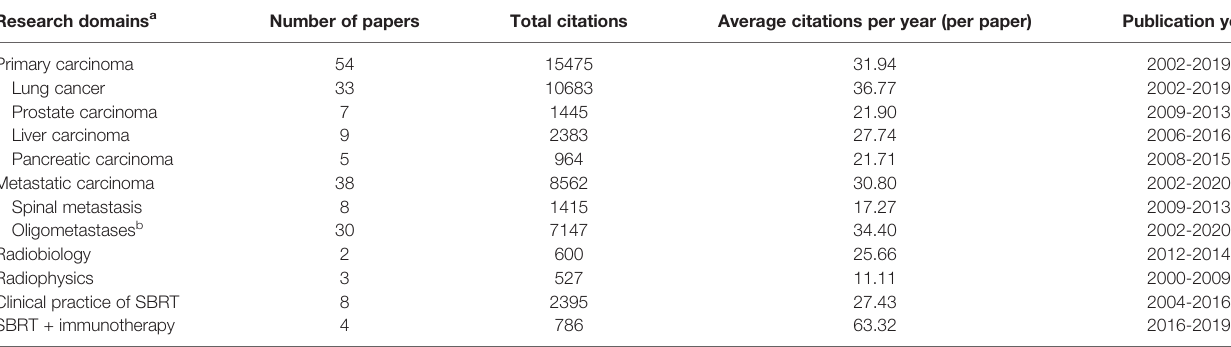
TABLE 3 | Research domains of the 100 most cited papers in SBRT until